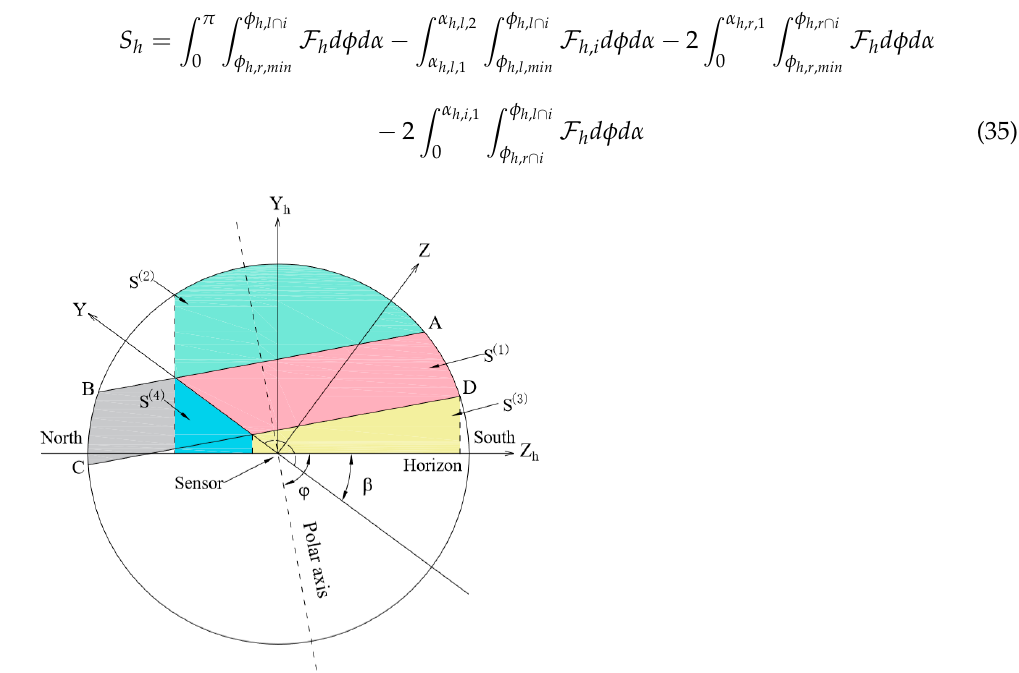
(7) While 𝑑 (cid:3045) ≤ 0 , 𝜙 (cid:3035),(cid:3039),(cid:3040)(cid:3028)(cid:3051) ≥ 𝜙 (cid:3035),(cid:3039)∩(cid:3036) ≥ 𝜙 (cid:3035),(cid:3039),(cid:3040)(cid:3036)(cid:3041) , 𝜙 (cid:3035),(cid:3045),(cid:3040)(cid:3028)(cid:3051) ≥ 𝜙 (cid:3035),(cid:3045)∩(cid:3036) ≥ 𝜙 (cid:3035),(cid:3045),(cid:3040)(cid:3036)(cid:3041) , shown as (7) While d r ≤ 0, φ h , l , max ≥ φ h , l ∩ i ≥ φ h , l , min , φ h , r , max ≥ φ h , r ∩ i ≥ φ h , r , min , shown as Figure 12, the axis Y is between the points A and B. T he Equation (5) can be written as Figure 12, the axis Y is between the points A and B. The Equation (5) can be written as